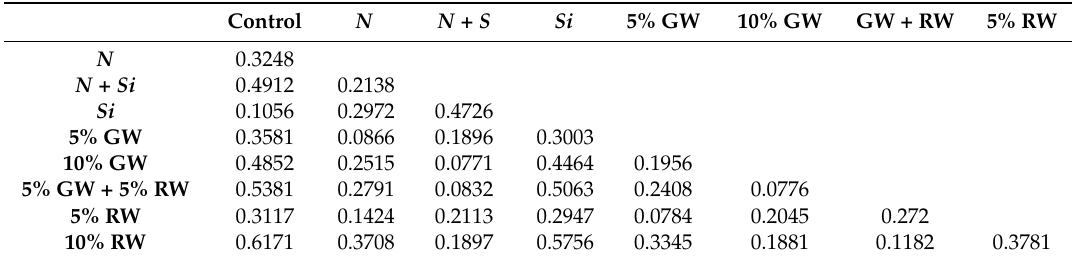
Figure 3. Cell concentrations (cells/mL) of different taxa for each treatment group. Stars indicate the treatment group is statistically different from the control using a Tukey-Kramer post hoc test ( p < 0.05). Table 3. Results of the Bray-Curtis test for dissimilarity of the cell count data.